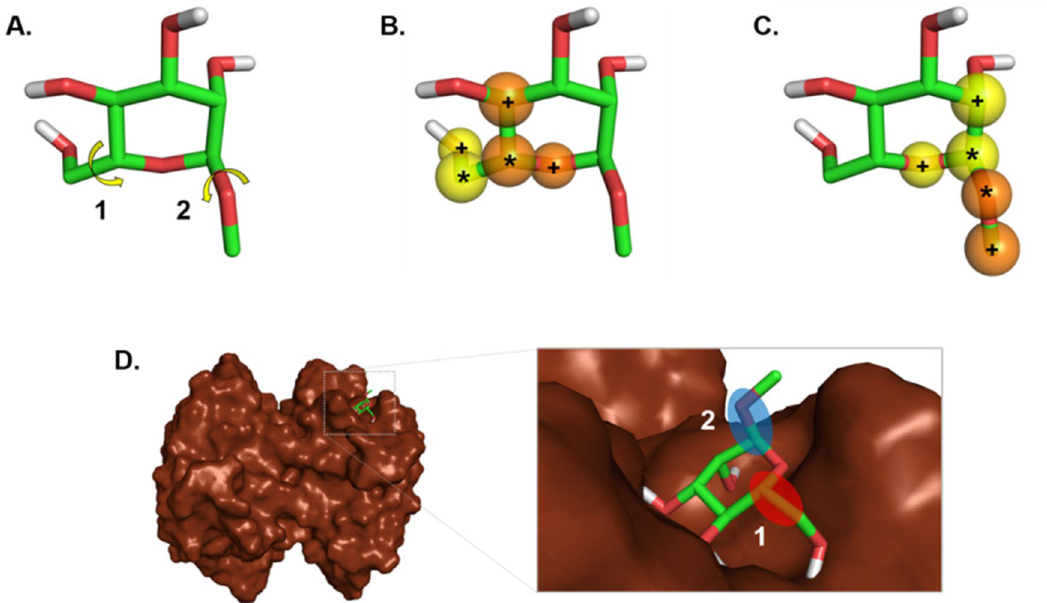
Figure 1. Illustration of the algorithm for computing the ligand torsional entropy term. ( A ) Selection of the rotatable bonds in the ligand. ( B and C ). Each rotatable bond is divided into two sides (i in yellow and j in orange) and the root (*) and the neighboring ( +) atoms are detected. ( D ) A rotatable bond is considered as frozen if both sides become buried with more than 50% due to the binding (case 1). If at least one side does